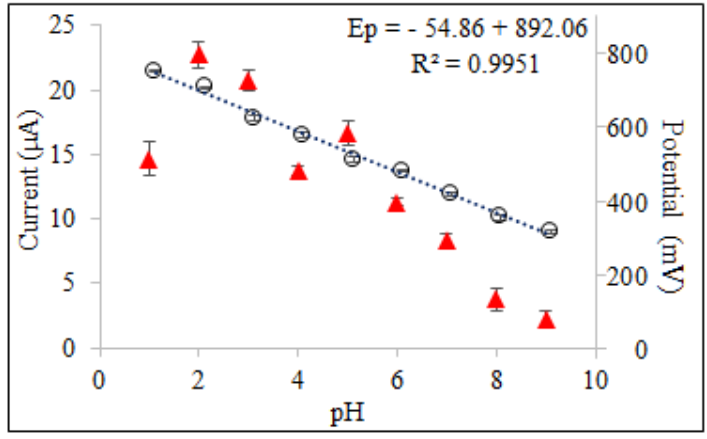
Figure 4. Effect of pH on peak potentials and peak currents obtained for 6.0 mg/L oxyclozanide in 0.1 M HCl and BR buffer using SWSV at CPE ( t acc = 60 s and E acc = 0 V).